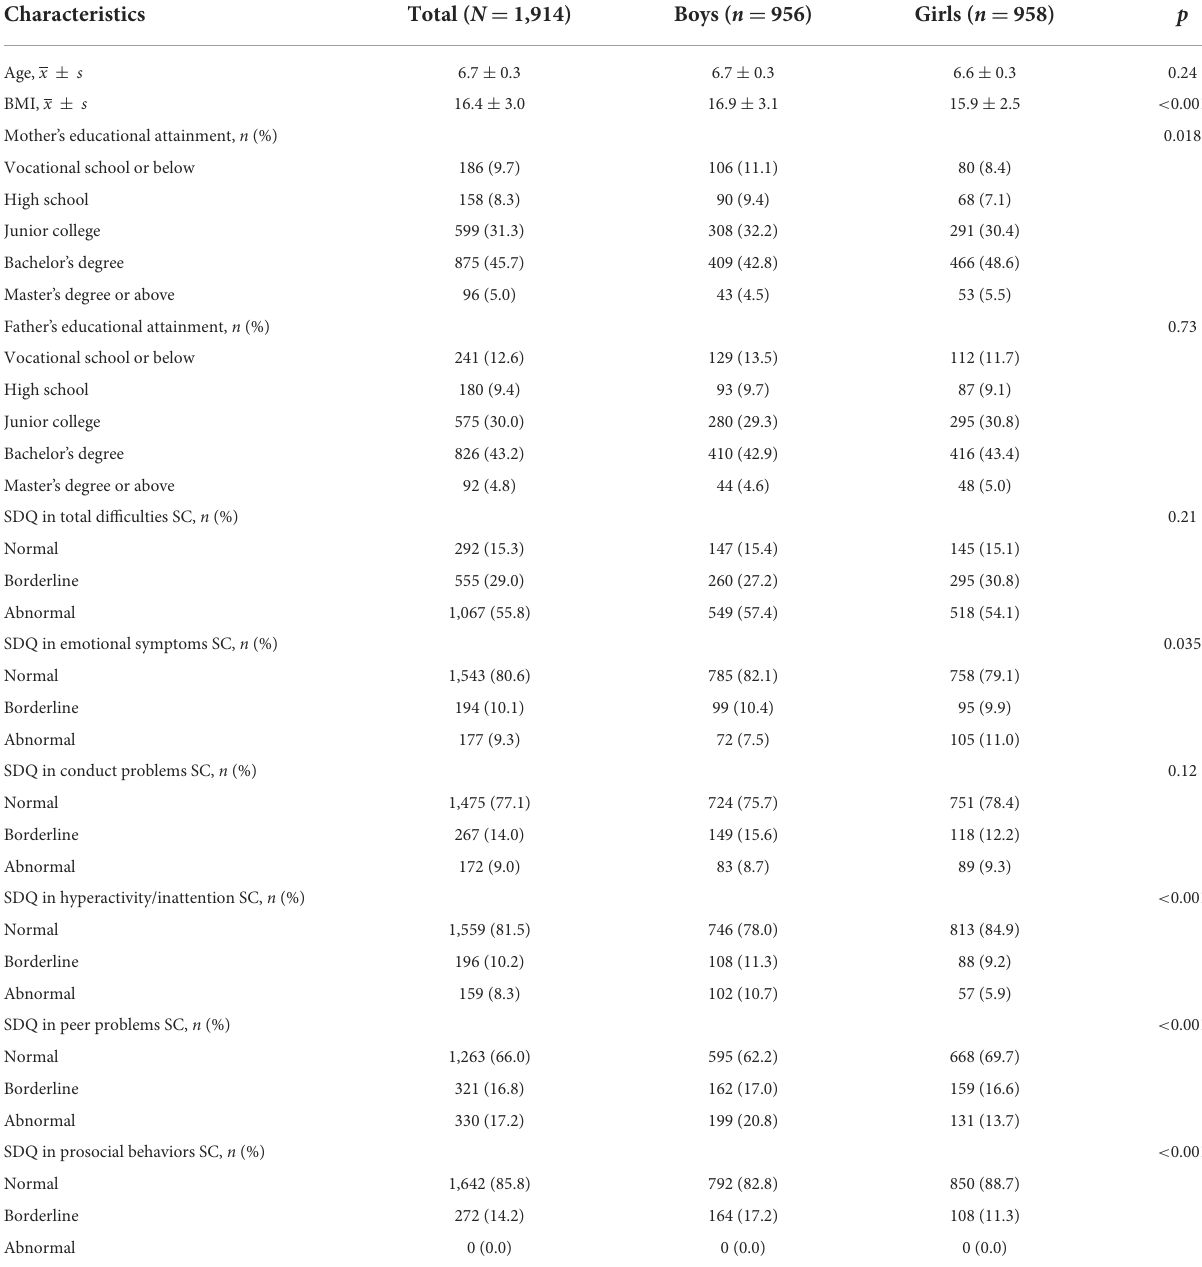
TABLE 1 Sociodemographic characteristics and the SDQ scores among 1,914 children aged 6–8 years in Beijing, China (imputed data).